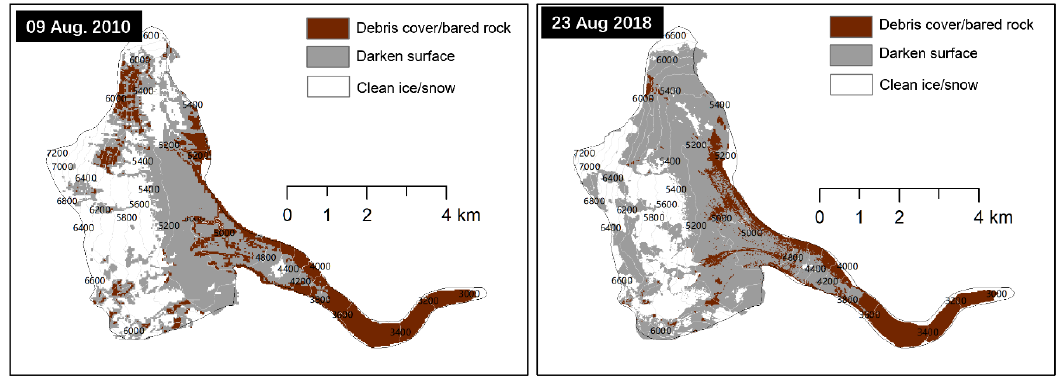
Figure 11. Changing areas of debris cover, darkened ice surface, and clean ice and snow on the Hailuogou glacier in 1990, 2000, 2010, and 2018. The various areas of the glacier in 1990 are overlaid to highlight the retreating and shrinking ice tongue.